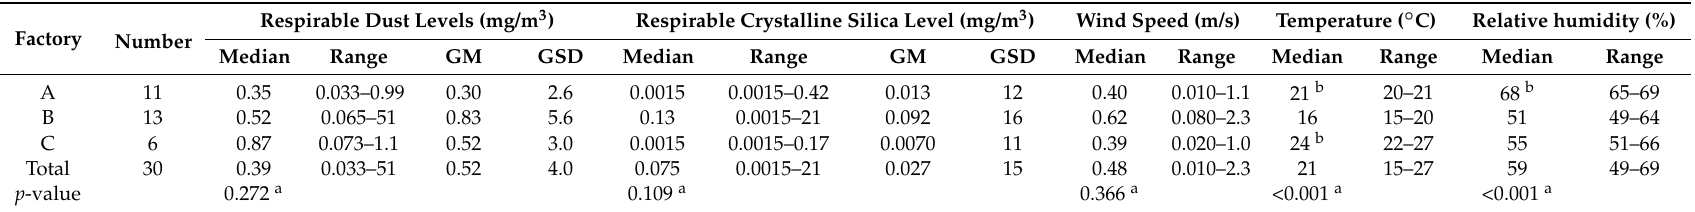
Table 1. Descriptive statistical parameters of respirable dust, respirable crystalline silica (RCS), and climatic factors at different